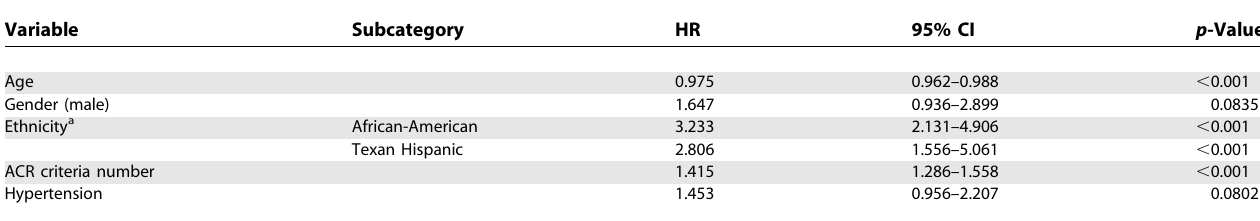
Table 3. Baseline Predictors of Time to Renal Involvement in PROFILE Patients by Cox Multivariable Proportional Hazards Regression